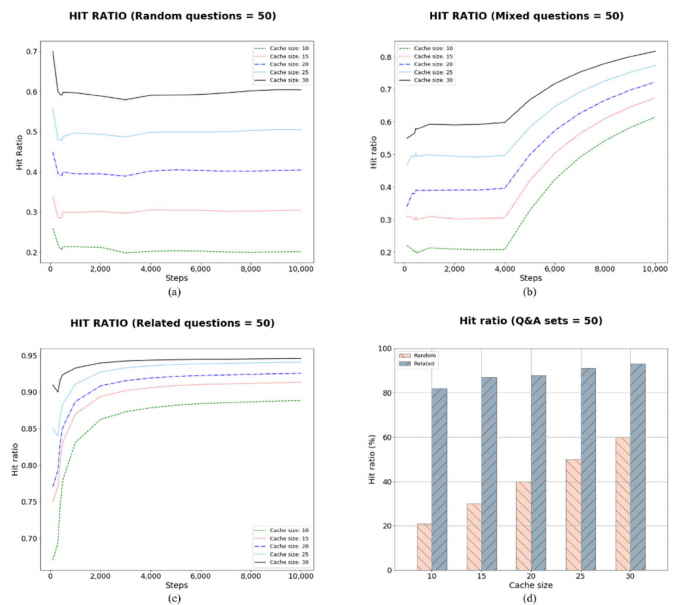
Figure 7. Experimental results of C1. ( a )—results of C1 with the random sequence; ( b )—results of C1 with the mixed questions sequence; ( c )—results of C1 with the related questions sequence; ( d )—the overall results of